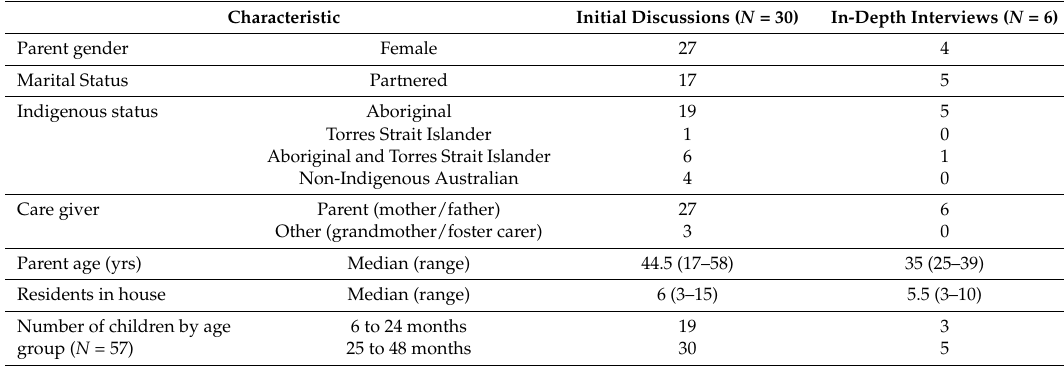
Table 1. Demographic characteristics of